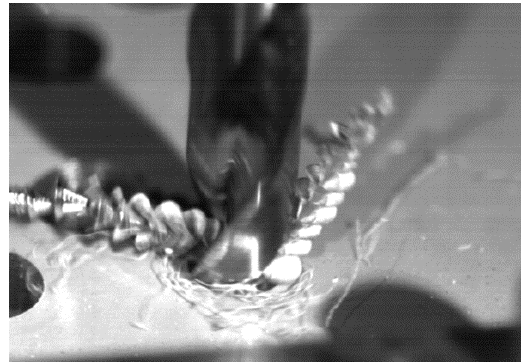
Figure 8. Chip evacuation during dry drilling of alloy UNS A97075.